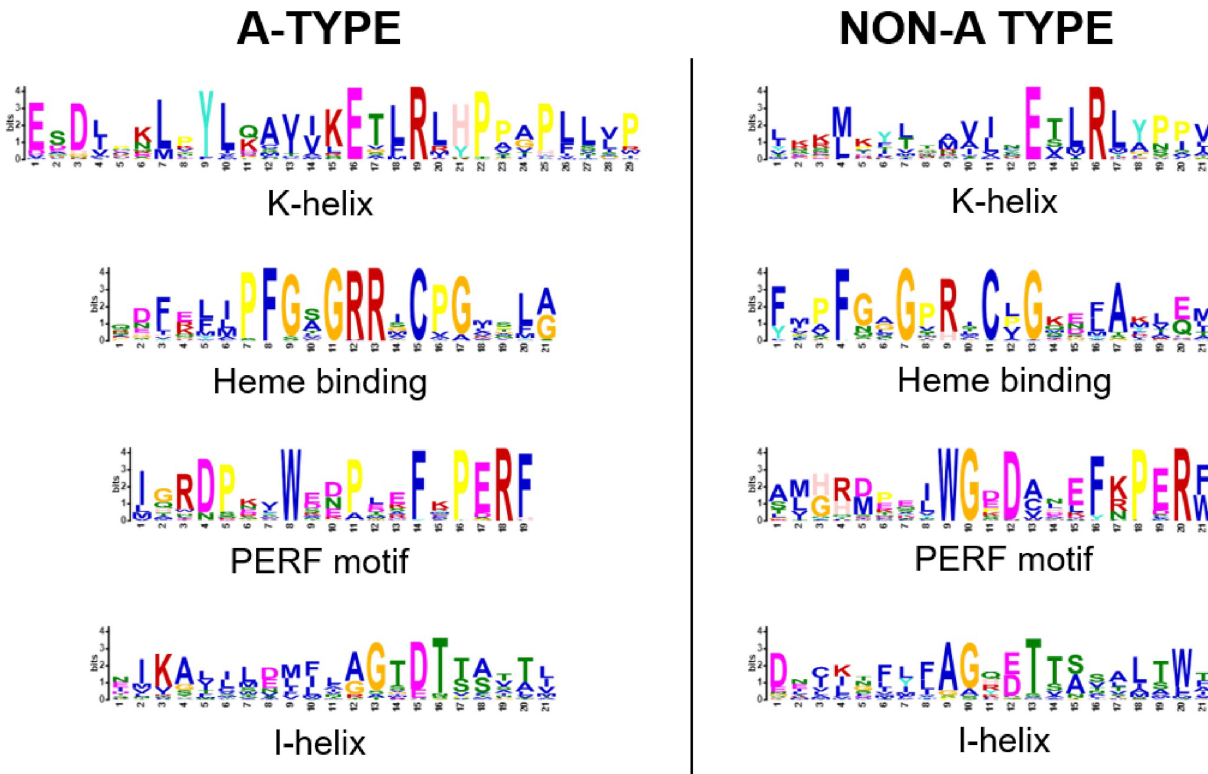
Fig 2. Comparison of sequence logos for conserved motifs of the predicted P450 proteins, A-type and non-A type, in durian. Sequence logos of the consensus motifs were created using MEME online software, containing stacks of letters at each position in the motif. The total height of the stack was the information content of that position in the motif in bits. The height of each letter represents the frequency of amino acids at the corresponding position.